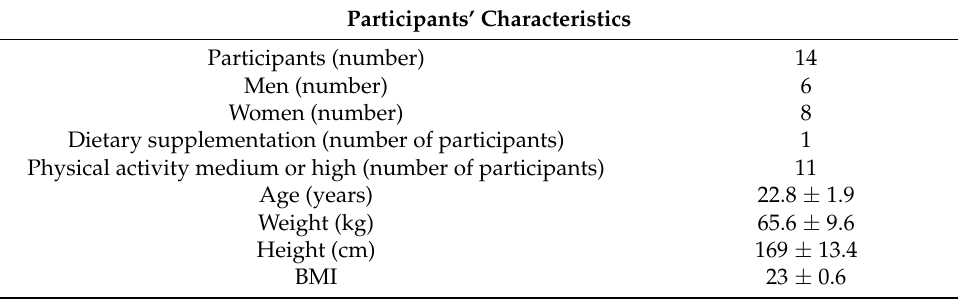
Table 3. Participants’ characteristics at baseline.